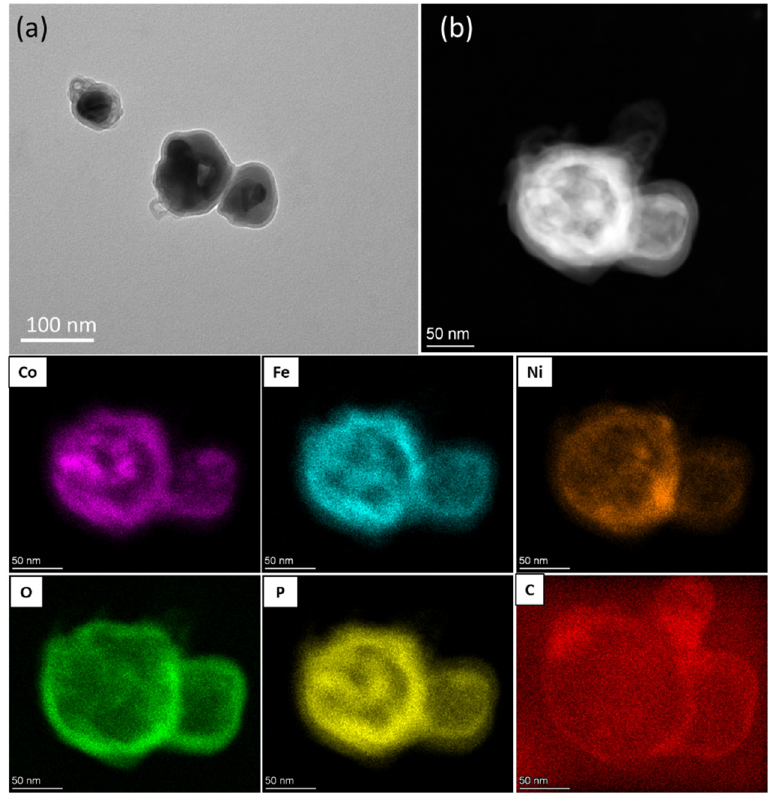
Figure 2. ( a ) TEM image, ( b ) HAADF image, and its corresponding EDX mapping of the Co, Fe, Ni, P, O, and C elements.